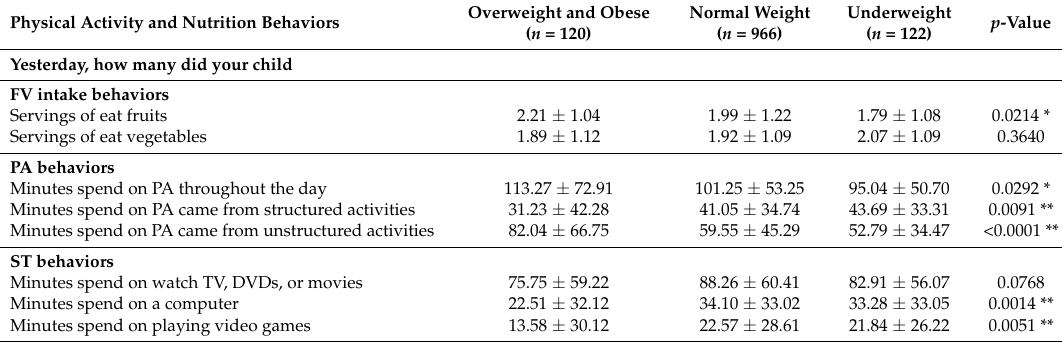
Table 2. Physical activity and nutrition behaviors of preschool Children by weight status (Mean ± SD).